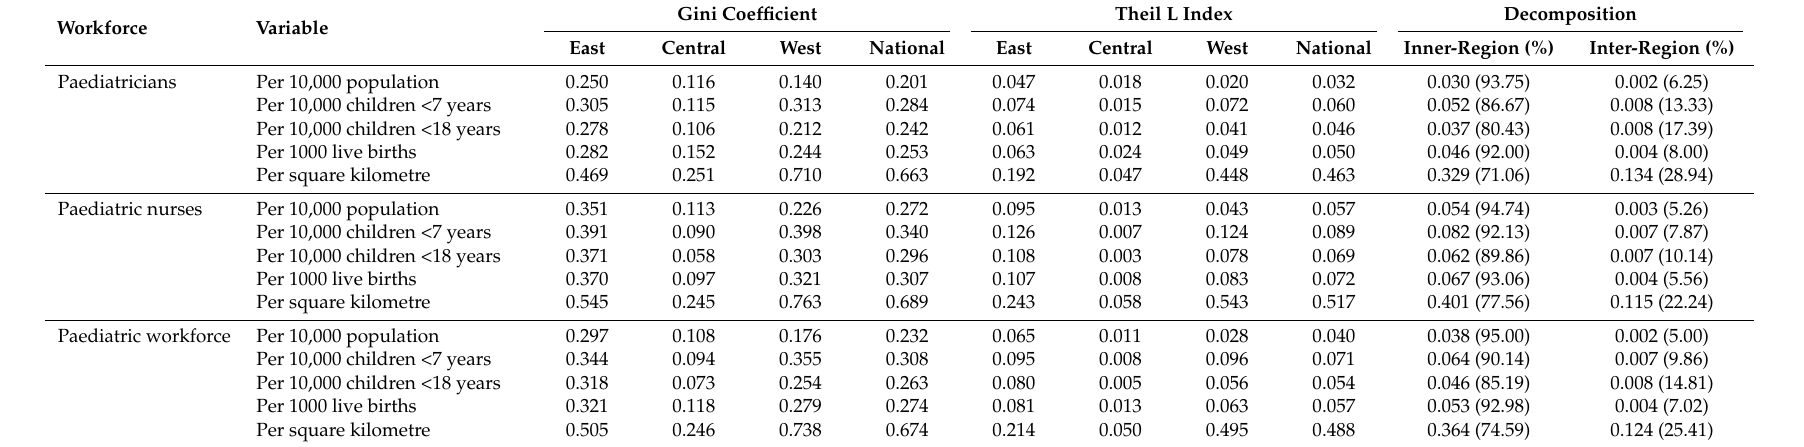
Table 1. Gini coefficients and Theil L index of different indicators in the three